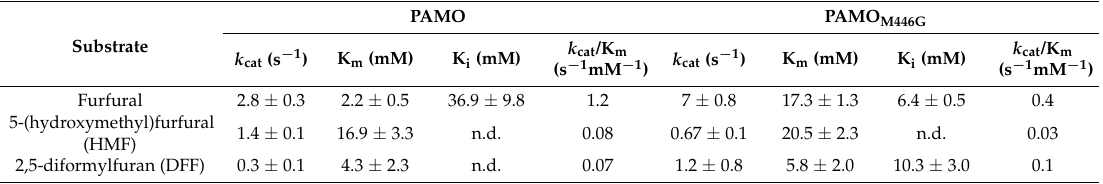
Table 1. Steady-state kinetic parameters of PAMO and PAMO M446G for furanoid aldehydes.